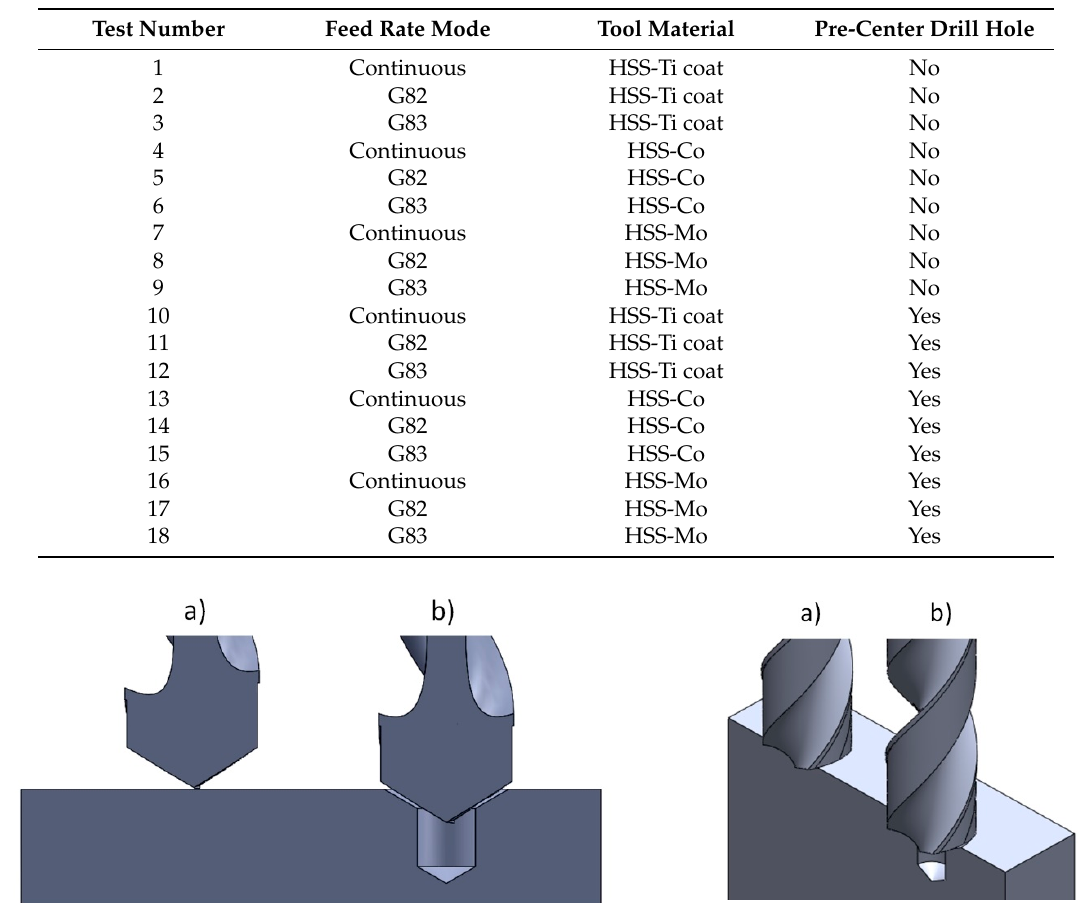
Figure 3. Drill position ( a ) without a pre-center drill hole; ( b ) with a pre-center drill hole.